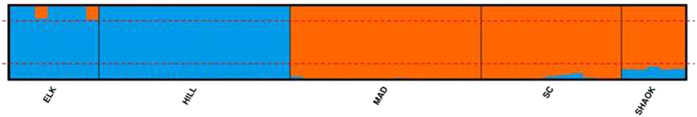
Plot of the Bayesian clustering analysis supported in STRUCTURE after computing posterior likelihood values for K = 1 to K = 6 for 53 clones on 32,313 SNPs.Two genetic clusters (i.e., K = 2) were estimated by the ΔK method of Evanno et al.19, regardless of the admixture model applied. Red dotted lines indicate the arbitrary 20% threshold for assignment to belong to a particular genetic cluster. For population/lake codes, please, refer to Table 1.